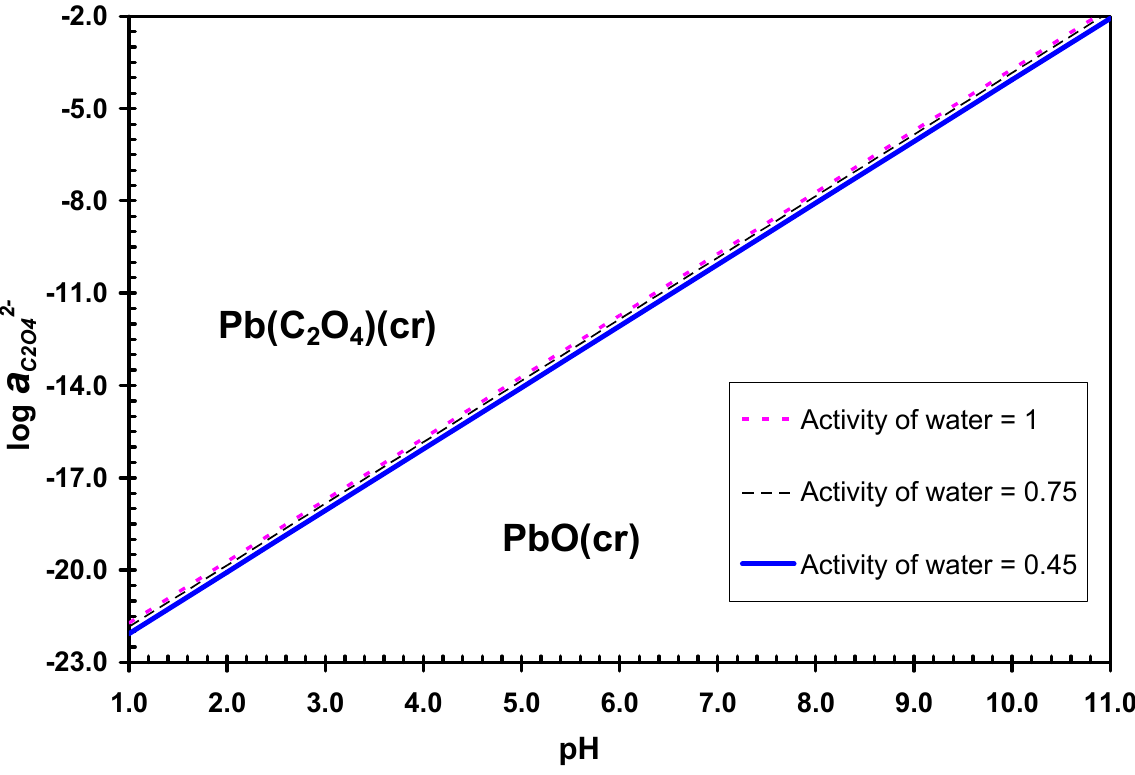
Figure 3. The stability fields of lead monoxide [PbO(cr)] and lead oxalate [PbC 2 O 4 (cr)] at 25 °C in the space of pH versus log a C 2 O 2 − 4 in an oxalate-bearing solution for desulphurization of lead pastes at water activities of 1.0, 0.75, and 0.45.